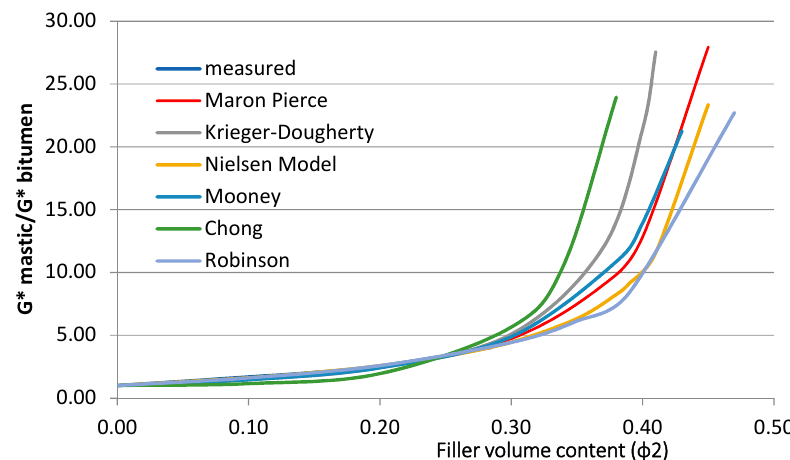
Figure 8. Stiffening ratios for limestone and granite.